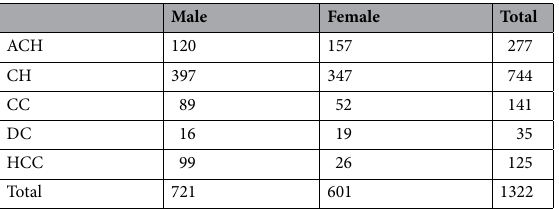
Table 3. Characteristics of patients with hepatitis B. ACH asymptomatic chronic hepatitis, CH chronic hepatitis, CC compensated cirrhosis, DC decompensated cirrhosis, HCC hepatocellular carcinoma.